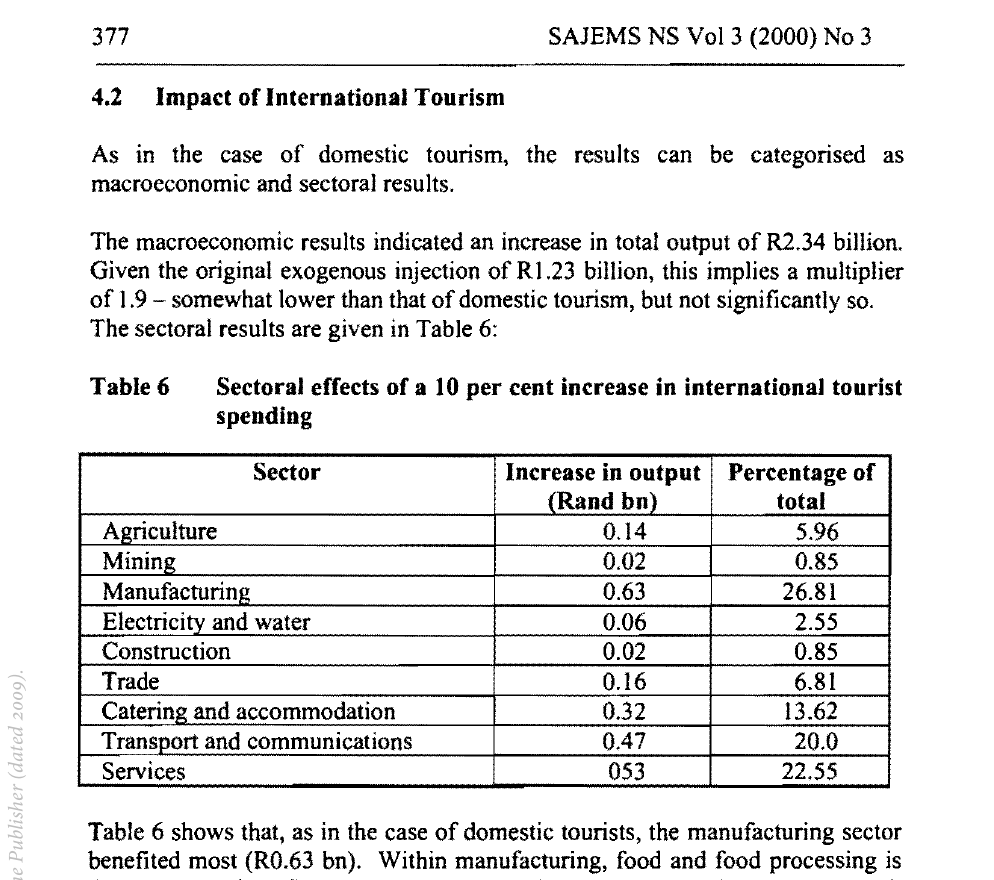
Sectoral effects of a 10 per cent increase in international